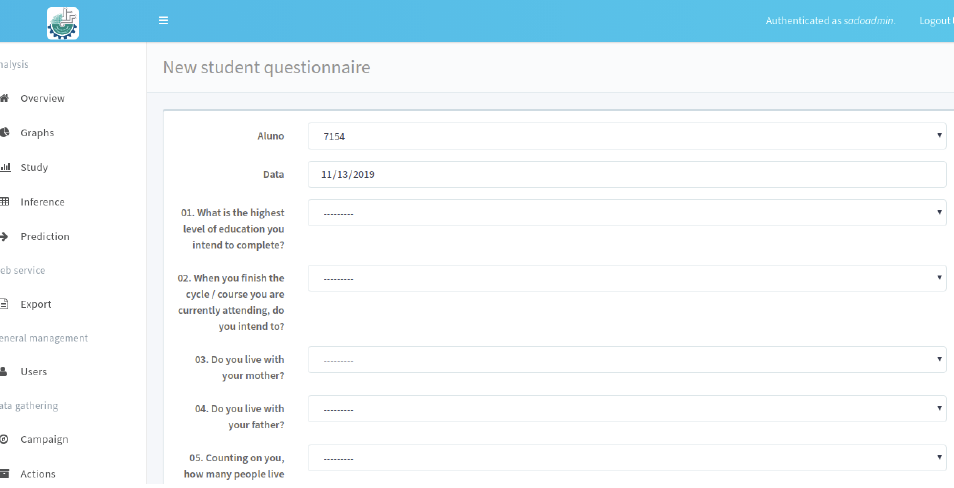
Figure 12. Questionnaire fragment applied to student’s. Source: Figure elaborated by the own